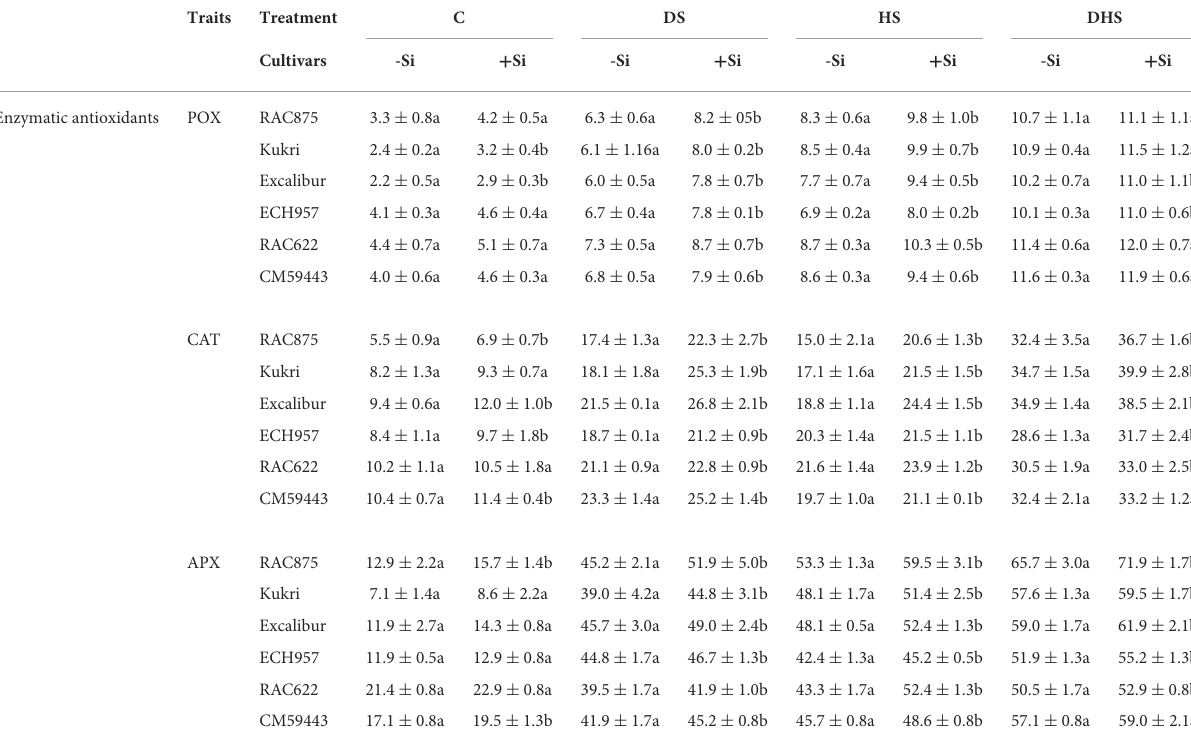
TABLE 1 Activity of enzymatic antioxidants of six contrasting wheat cultivars under drought stress (DS), heat stress (HS), and drought-heatcombined stress (DHS) in controlled glasshouse conditions. Traits Treatment